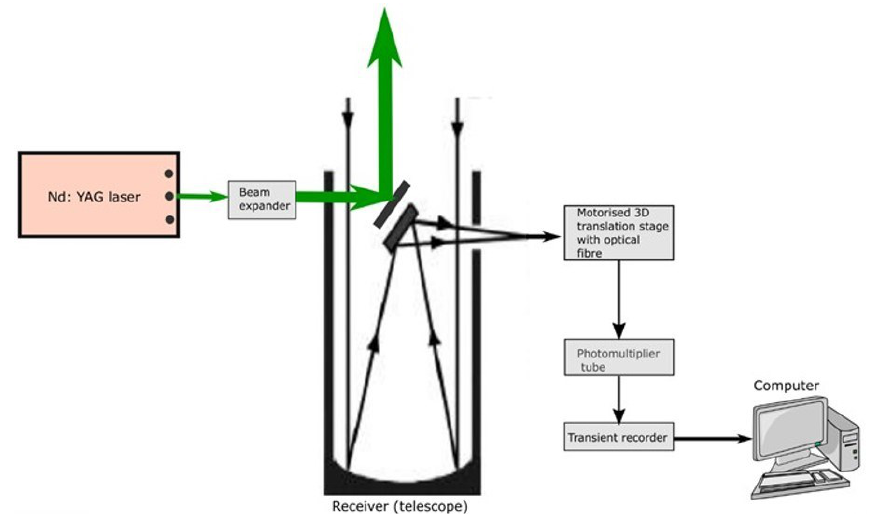
Figure 2. Schematic diagram for UZ lidar system.